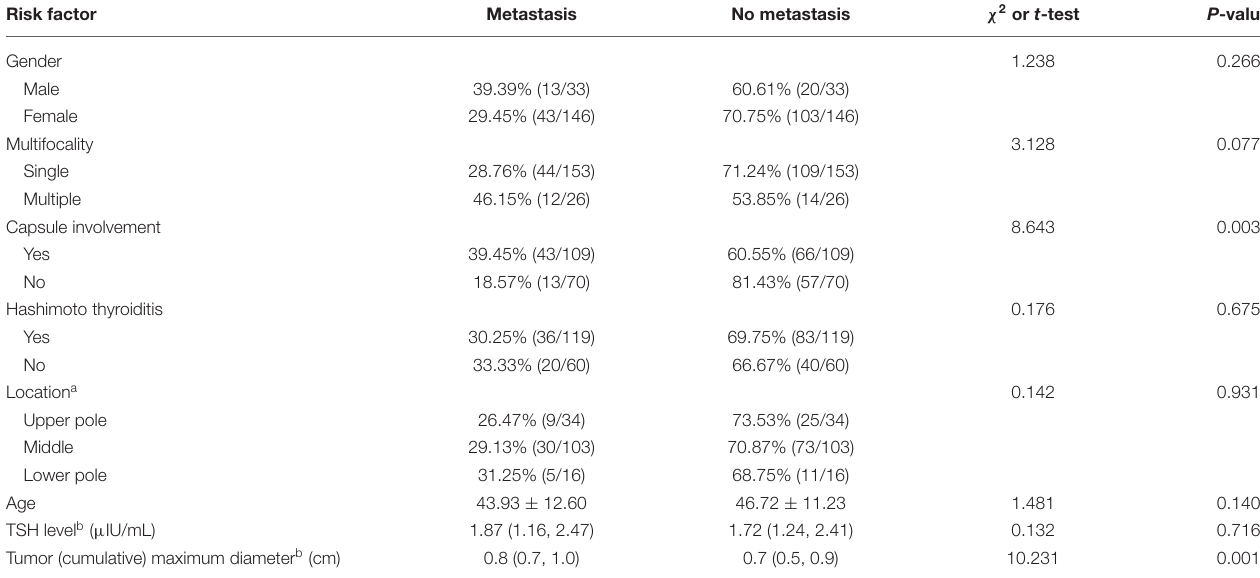
TABLE 2 | Univariate analysis of CNM in papillary thyroid microcarcinoma.